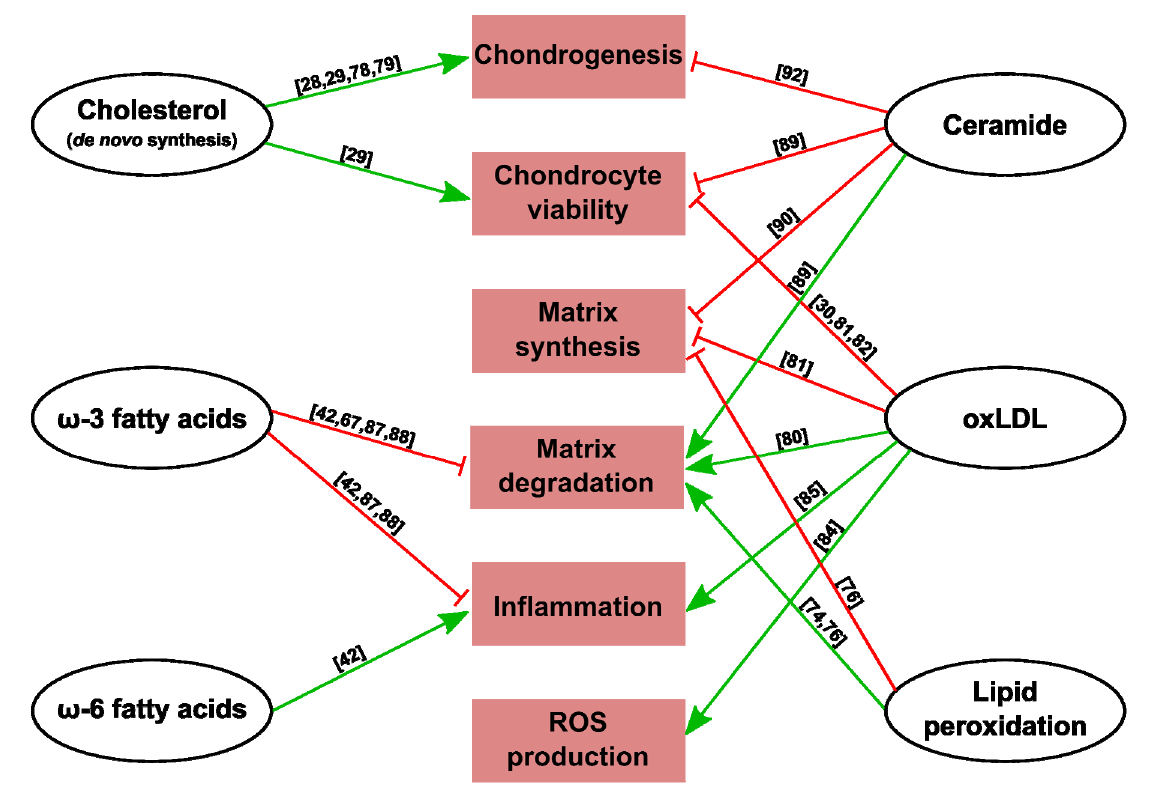
Figure 1. Summary of lipid actions in cartilage metabolism and response to stress. Green arrows indicate activation and red arrows inhibition of the processes shown in the squares. References are indicated in